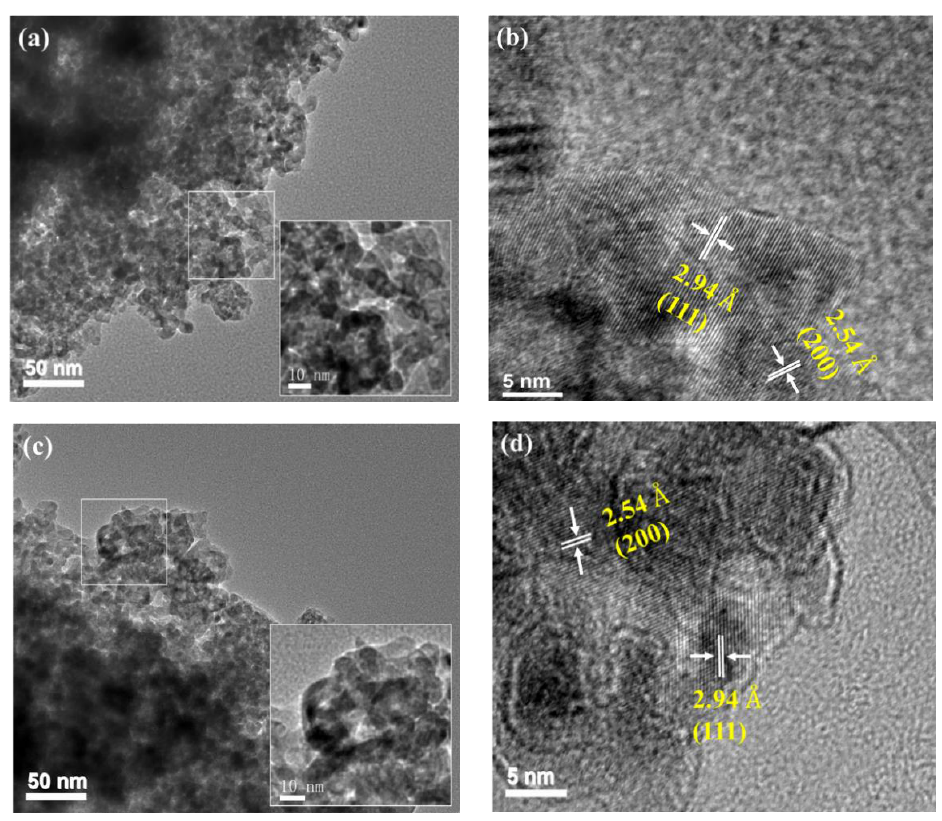
Figure 3. High resolution transmission electron microscope (HRTEM) images of CP-Mn2Zr3 ( a , b ) and TP-Mn2Zr3 ( c , d ).